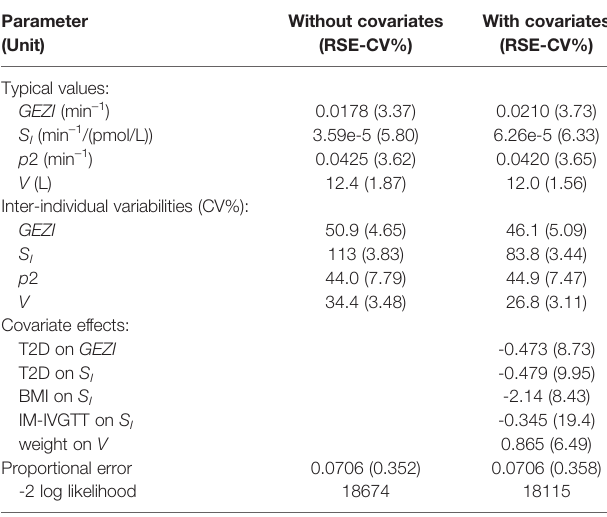
TABLE 3 | Population modeling